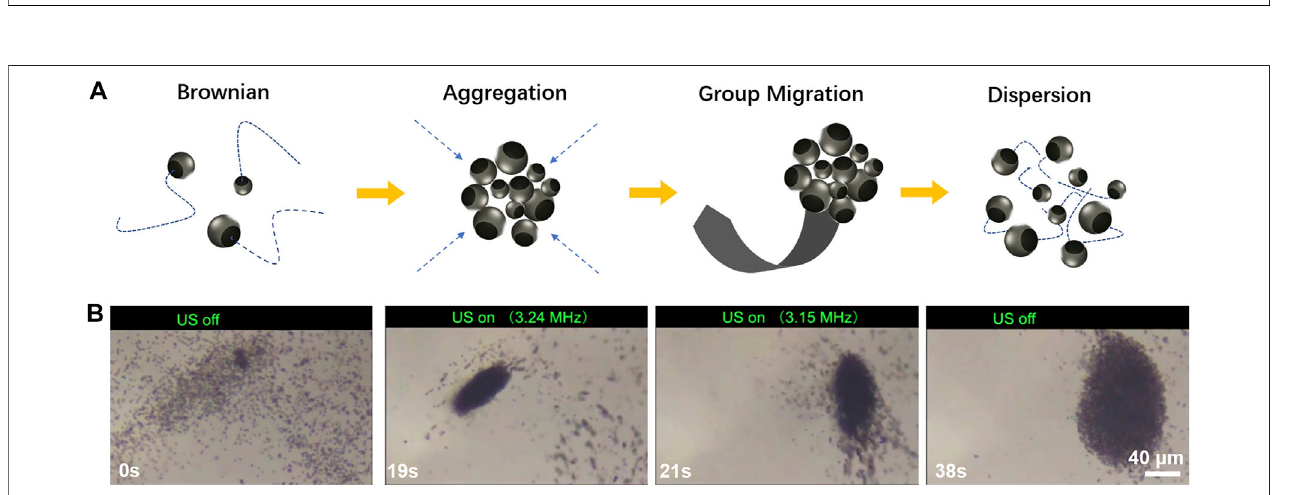
Frontiers in Bioengineering and Biotechnology |